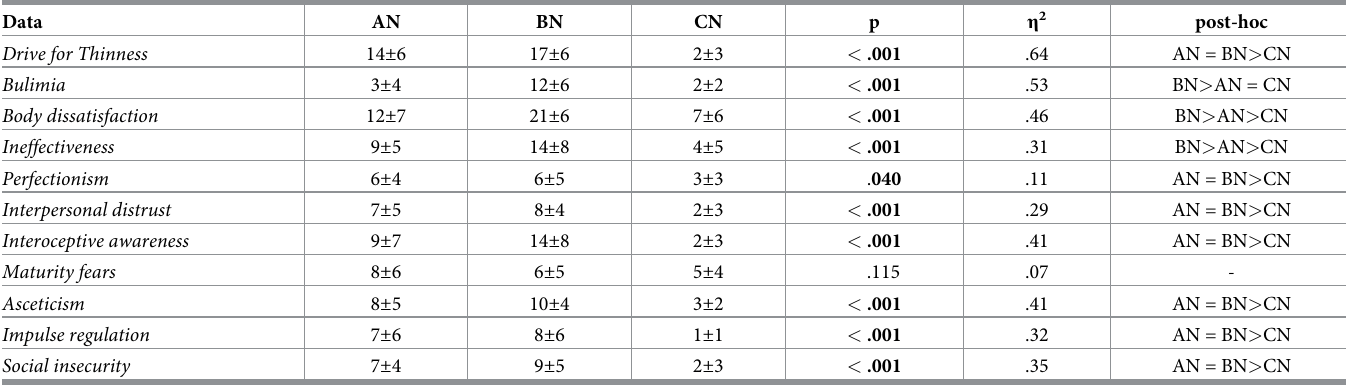
Table 2. Eating disorders inventory 2 scores for the three